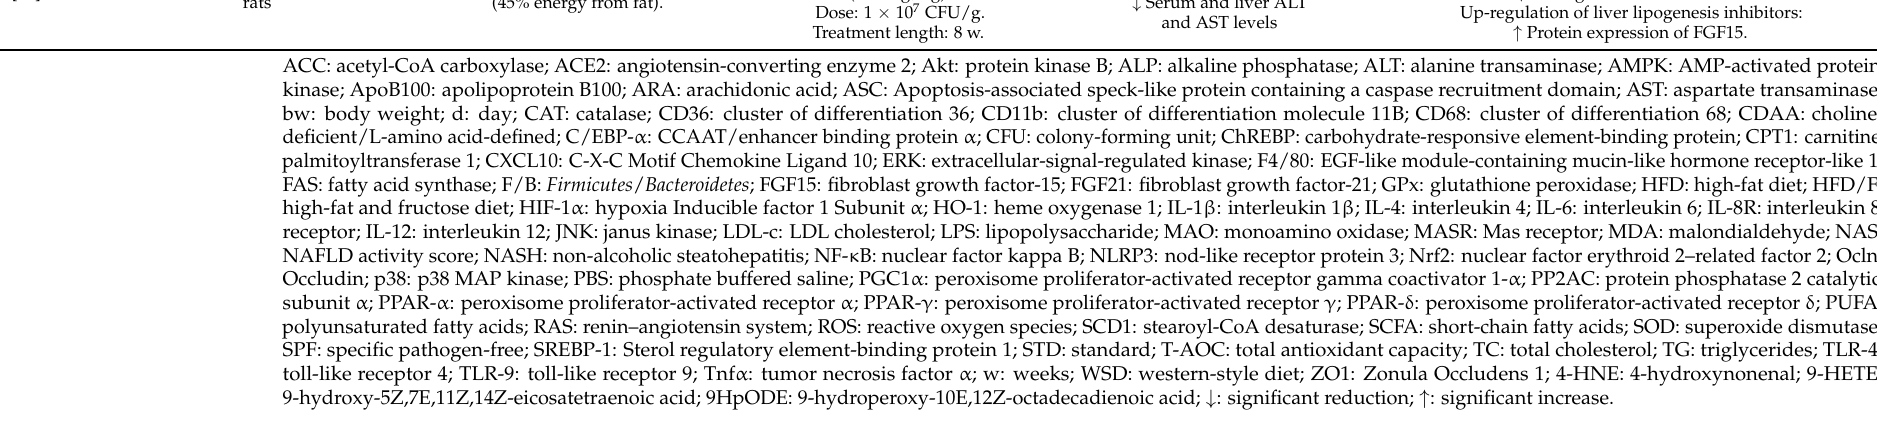
↓ Liver lipid content ↓ Liver inflammation ↓ Serum and liver ALT and AST levels